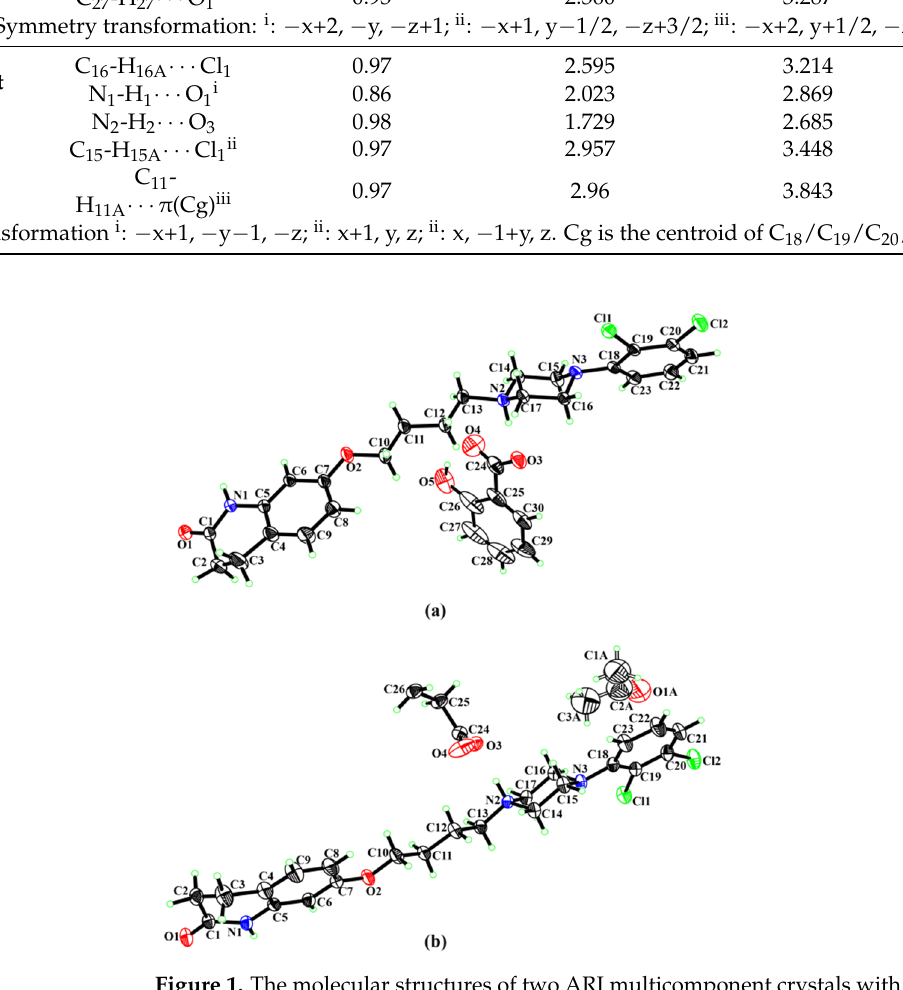
Symmetry transformation i : −x+1, −y−1, −z; ii : x+1, y, z; ii : x, −1+y, z. Cg is the centroid of C 18 /C 19 /C 20 /C 21 /C 22 /C 23 atoms ARI-SAL salt. The ARI-SAL salt crystallized in the monoclinic P2 1 /c space group with an aripiprazole cation, balanced by a salicylic counter-ion, in the asymmetric unit (Figure 1a). The O 5 atom of salicylic anion presented positional disorder over two sites with a 0.6: 0.4 site-occupancy. ARI-SAL salt, like other lactam compounds, formed a cen- motif with its inversion-related molecule [32]. Inter- estingly, the dimer formed a 1D ribbon through the short Cl 1 … O 1 interaction, which formed another new dimeric substructure (Figure 2a). Furthermore, the dimer units were arranged helically into the three-dimensional network (Figure 2b) by the bifurcated N-